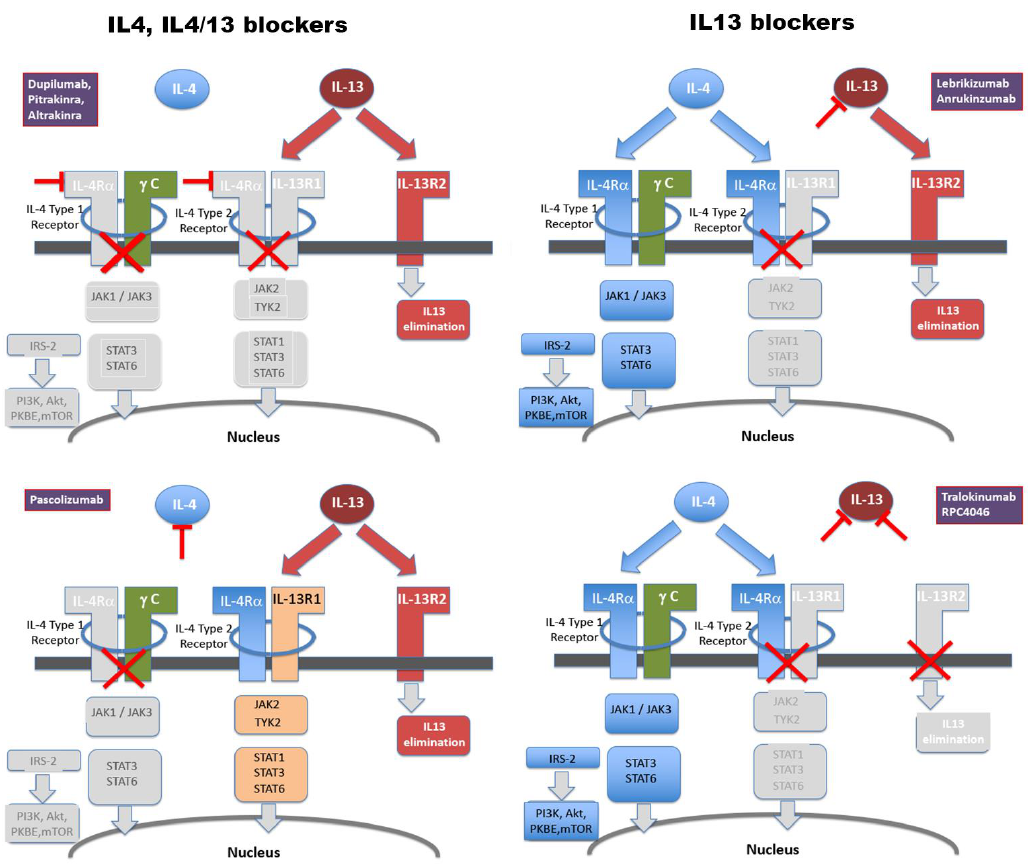
Figure 1. Molecular targets of monoclonal antibodies clinically evaluated to inhibit IL4 / IL-13 signalling